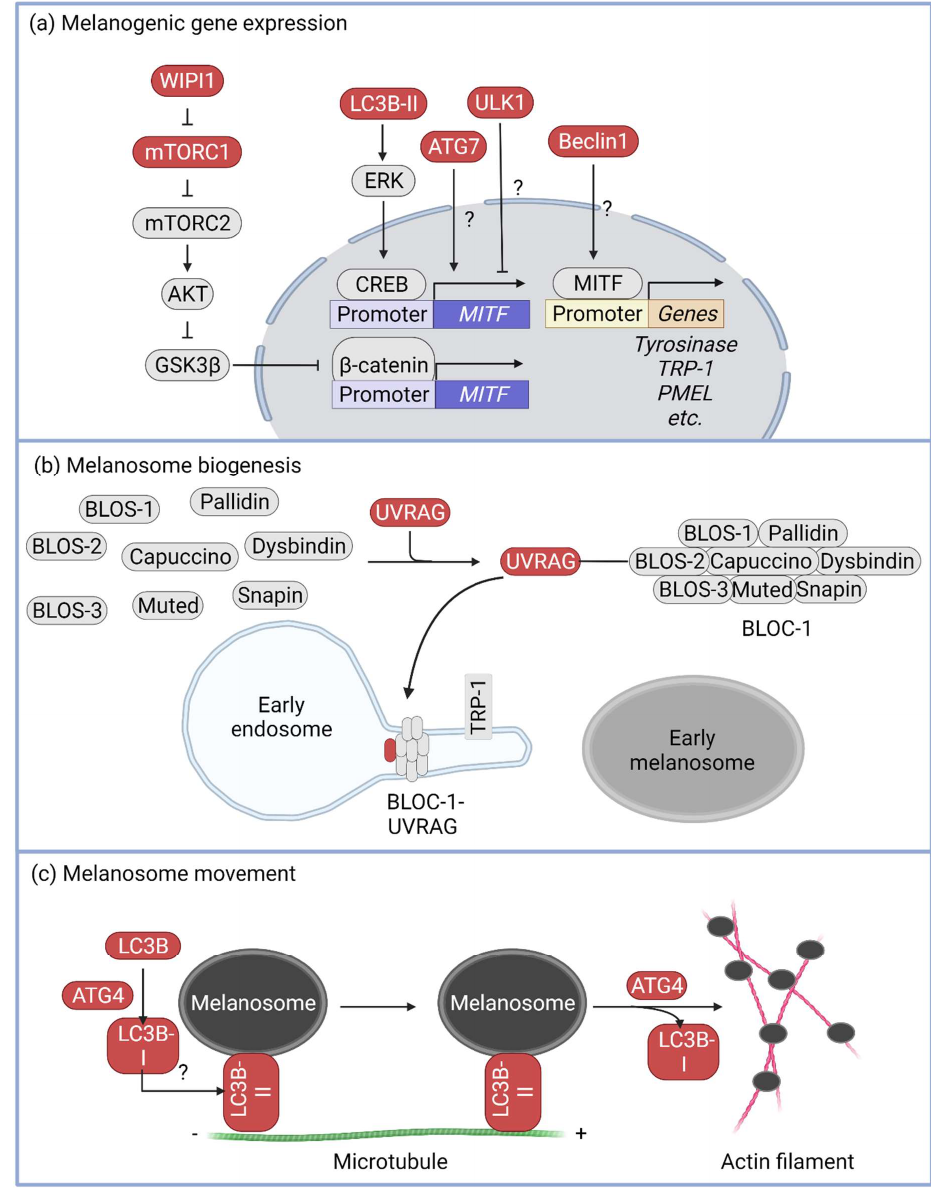
Figure 3. Autophagy machinery in melanogenesis. Autophagy machinery is related to melanogenesis in various steps. ( a ) In step 1, the melanogenesis-related gene expression step, MITF expression is regulated by WIPI1, LC3B-II, and ATG7. WIPI1 increases MITF expression through upregulation of β-catenin stability via GSK3β inhibition. LC3B-II induces ERK activation, and ERK increases MITF expression via phosphorylating CREB, whereas ATG7 and beclin-1 are positively related to MITF expression and MITF transcription activity, respectively, and ULK1 plays a negative role in melanogenesis. However, the precise mechanisms underlying these processes remain unclear. ( b ) In step 2, the melanosome biogenesis, UVRAG interacts with the BLOC-1 complex and upregulates its protein stability. ( c ) In step 3, the melanosome movement, LC3B is incorporated into the